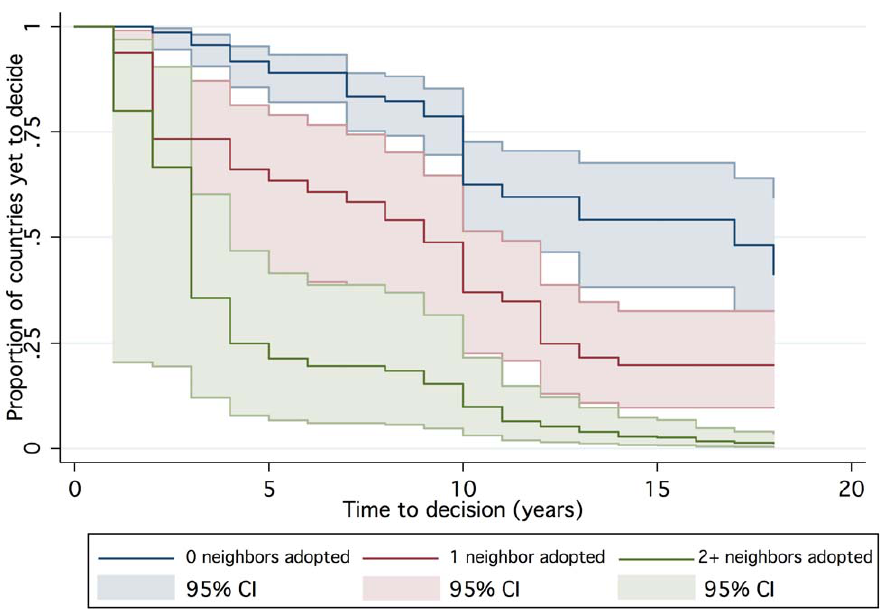
Figure 3. Time to decision by neighboring country adopters.